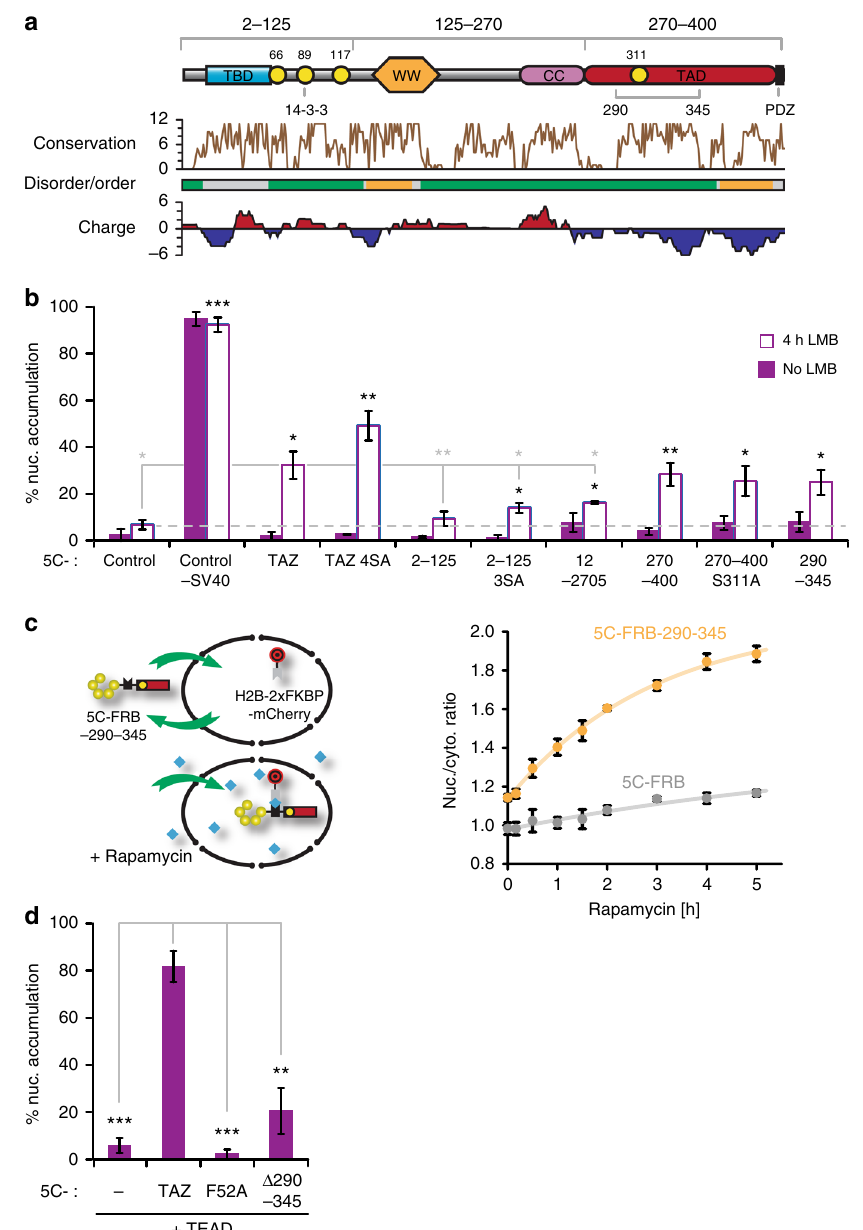
Fig. 3 Identi fi cation of the TAZ-NLS. a Domain architecture of TAZ and TAZ fragments used in ( b ). LATS-phosphorylation sites S66, S89, S117, and S311 are shown as yellow circles. The sequence conservation plot was calculated using Jalview 78 . Disordered (green) and ordered (orange) regions were calculated with SPOT-Disorder 79 and Metadisorder 80 . For regions in gray, predictions were not consistent. The charge plot represents local charges, averaged over a 19-residue window. Positive values are in red, negative values in blue. CC: coiled-coil region; PDZ: PDZ domain binding site; TAD: transactivation domain; TBD: TEAD-binding domain; WW: WW domain; 14 – 3 – 3: 14 – 3 – 3 binding site. b Nuclear enrichment of 5C-TAZ fragments without and with 4h LMB treatment, n = 3. Black and gray asterisks indicate signi fi cantly higher and lower nuclear accumulations in the presence of LMB, relative to control and 5C-TAZ, respectively. c RIS ’ N model showing rapamycin-induced nuclear entrapment of 5C-FRB-290 – 345 by H2B-2xFKBP-mCherry. Right: Median R N/C values for 5C-FRB-290 – 245 (orange) and 5C-FRB (gray, control) were plotted against time of rapamycin treatment, n = 3, 4, or 7 for various time points. Statistically signi fi cant differences between the two probes were observed at all time-points ( p < 0.01, not indicated). Curves are fi ts to an exponential rise to maximum function. d TEAD-mediated nuclear entrapment of WT and mutant 5C-TAZ constructs, n = 3. Data are represented as means ± SD. * p < 0.05, ** p < 0.01, *** p < 0.001; Student ’ s t